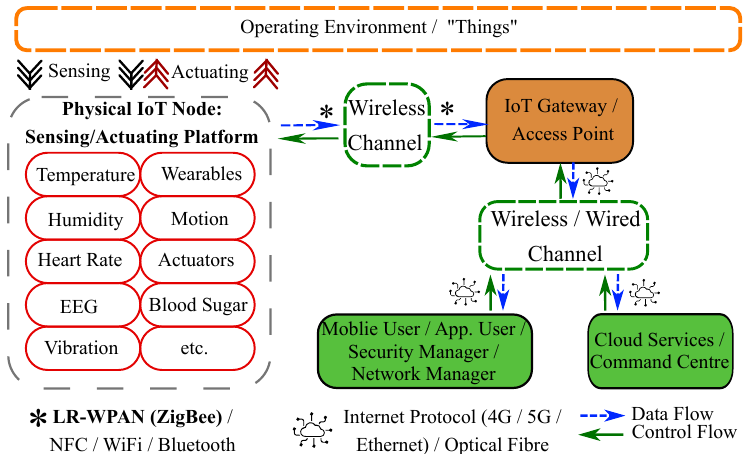
Figure 1. An example IoT architecture showing the potential utilization of WSNs and the security vulnerability produced by the wireless